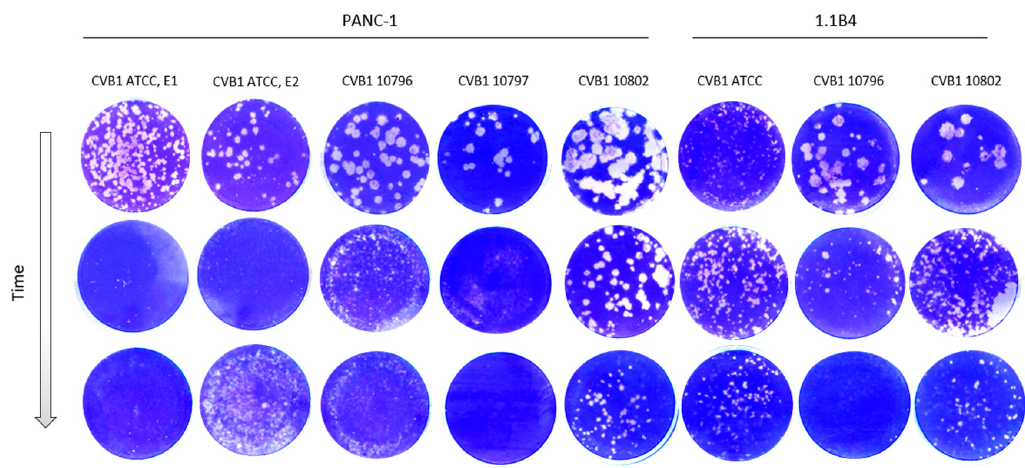
Figure 3. Plaque morphology of each PIDV over time. Plaque size reduces over time during the development of persistence in PANC-1 and 1.1B4 cell lines with the exception of ATCC-PIDV [1.1B4] (6th column).